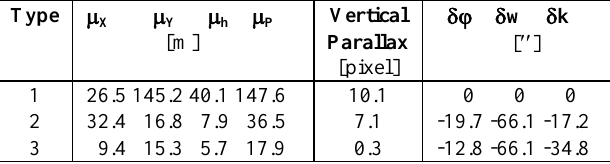
Table 2. Statistics of location accuracy and the compensation values using three